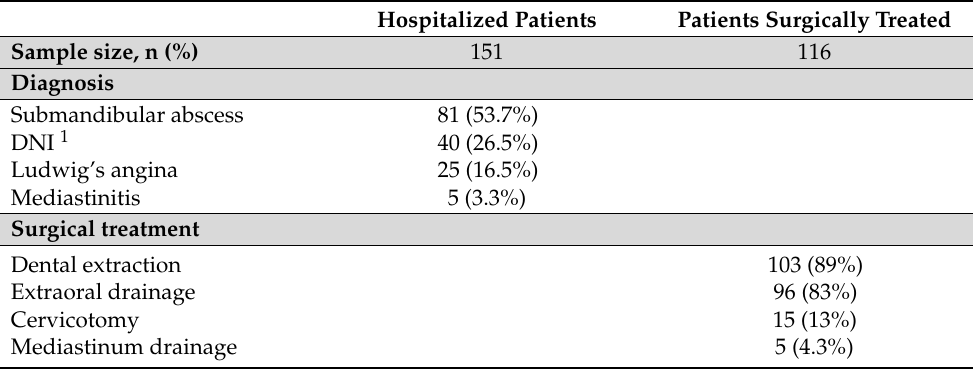
Table 2. Hospitalized patients: diagnosis and